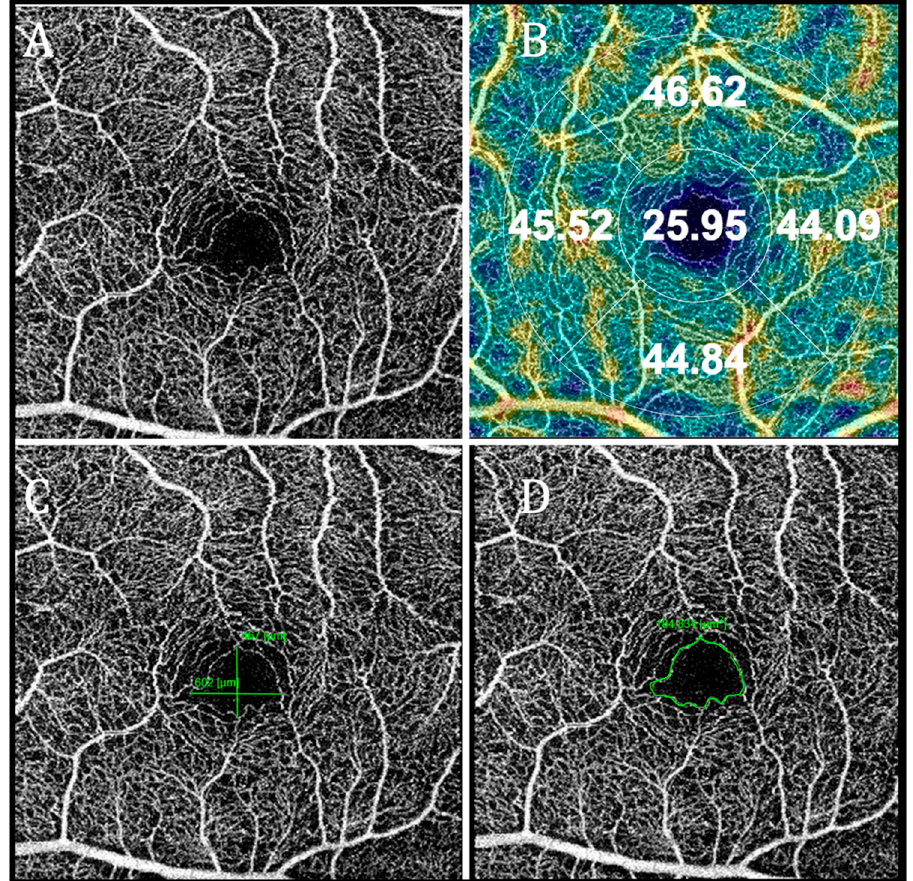
Figure 3. Images of optical coherence tomography angiography of superficial capillary plexus. ( A )—automatically formed image; ( B )—automatically formed image of vascular density values; ( C )—manually drawn vertical and horizontal length of foveal avascular zone; and ( D )—manually outlined foveal avascular zone.